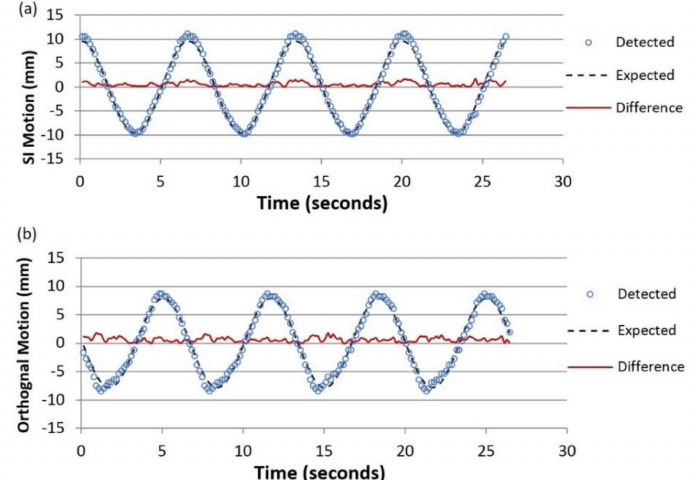
Figure 4. Lung tumor trajectory detected for a single fraction in two directions, ( a ) for superior–inferior (SI) and ( b ) for orthogonal direction against the expected trajectory used as ground truth for a gantry angle of 330 ◦ with regular motion R20 (range of 2 cm). The difference between the detected and the expected tumor positions are indicated for every frame by the squiggly red